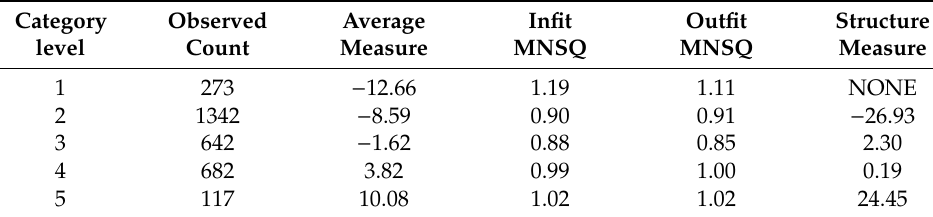
Table 6. Rating scale analysis of the K-PSI-SF.